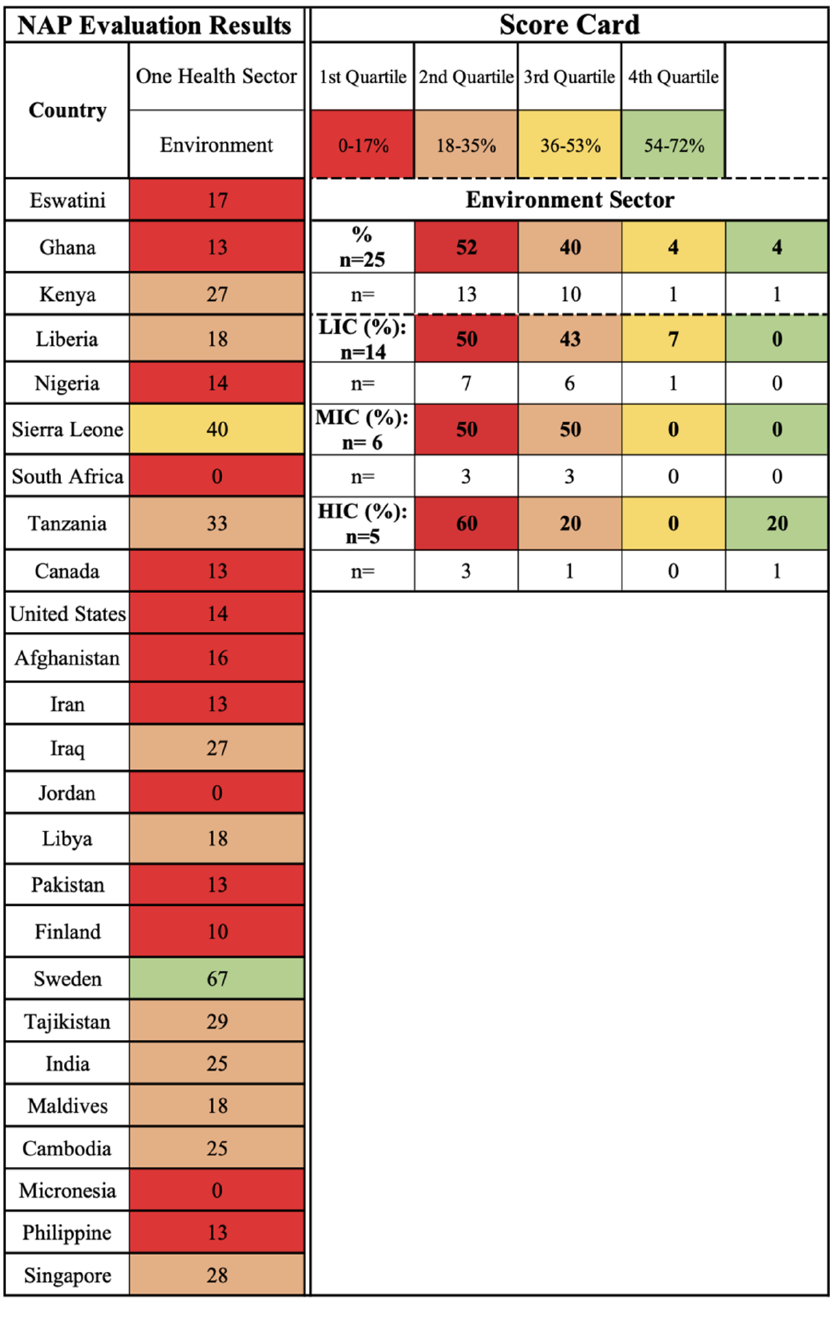
Figure 6. One Health environment sector scorecard by country and income level.